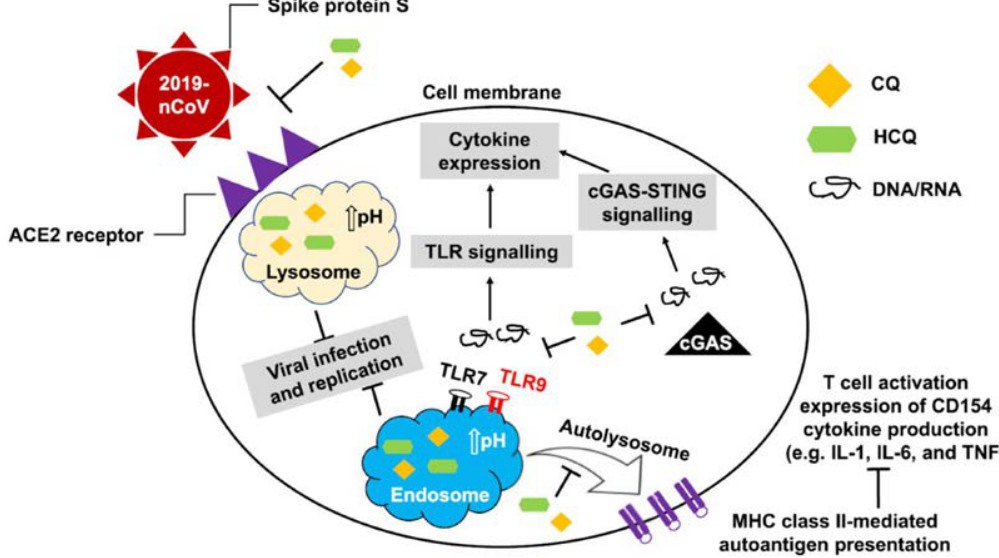
Fig. 8. Graphical illustration of mechanism of action of CQ and HCQ that not only reduce the binding efficiency of ACE2 on host cell and spike protein of the coronavirus and prevents replication but CQ and HCQ also attenuates the possibility of cytokine storm. Reproduced with permission from